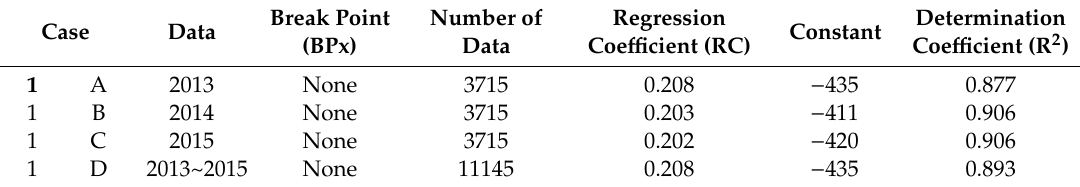
Table 6. Quadratic regression analysis result.